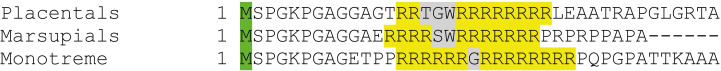
Comparison of the arginine cluster in the N-terminally extended signal peptides in mammals.Placentals and marsupials—consensus sequences, monotremes–platypus, see S2, S4 and S6 Figs. The initiating Met residues (green), the conserved Arg-residues (yellow) and the intervening amino acids (grey) are marked.